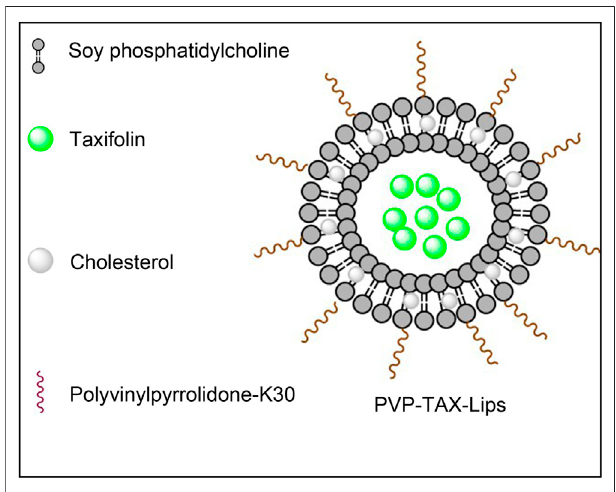
FIGURE 1 | The schematic diagram of the structure of